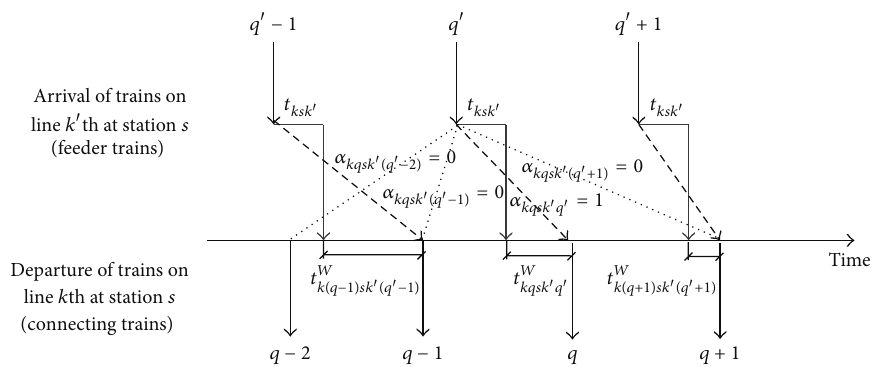
Figure 2: Illustration of transfer waiting time.